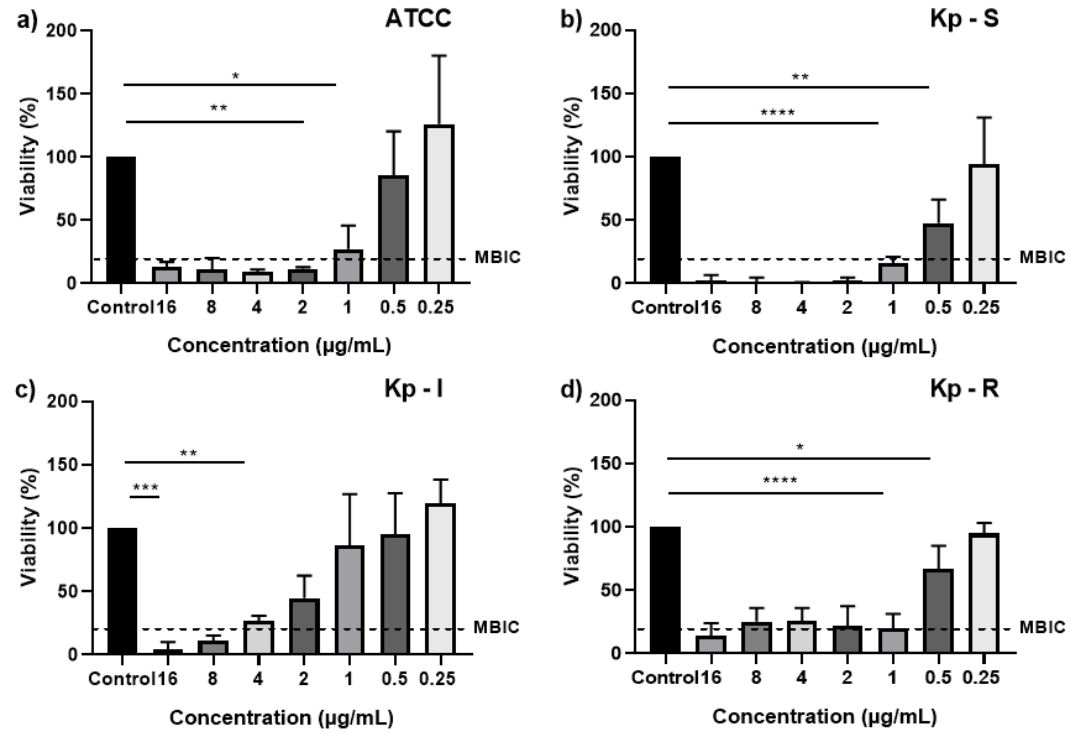
Figure 6. Viable cells in biofilms determined via the Resazurin assay after administration with AgNPs combined with Imipenem. ( a ) ATCC; ( b ) Kp-S; ( c ) Kp-I; and ( d ) Kp-R. Data are expressed as mean ± SD. * p < 0.05, ** p < 0.01, *** p < 0.001, **** p < 0.0001.